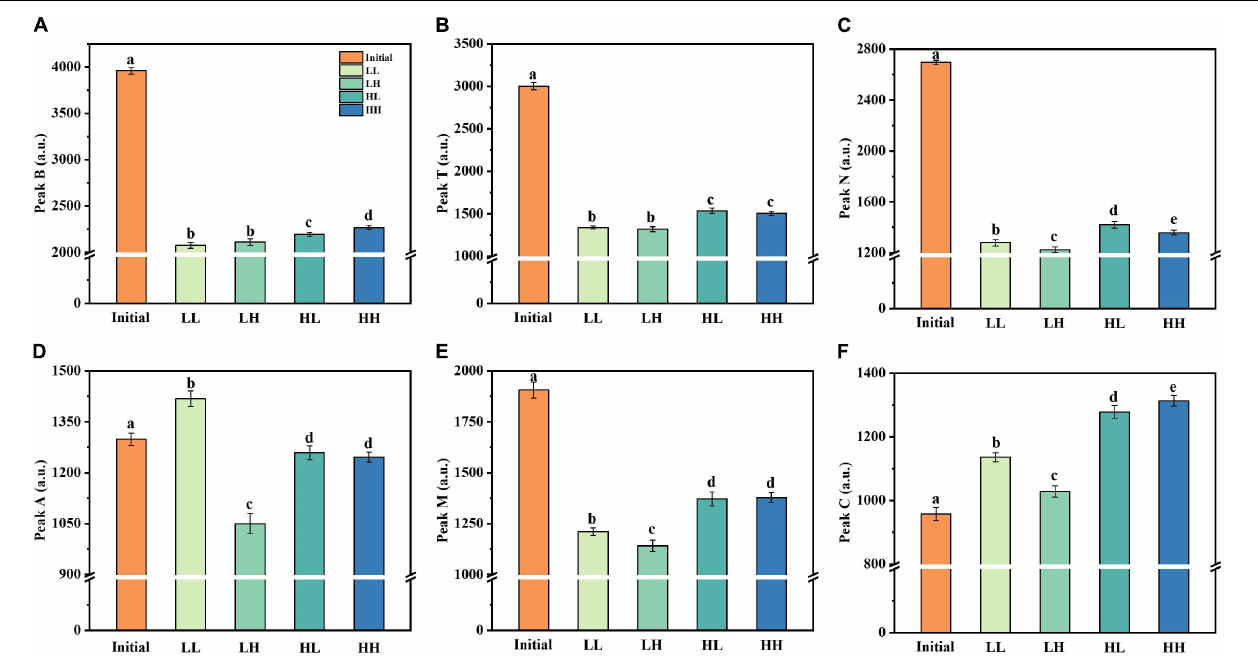
FIGURE 4 | Changes in fluorescence peaks (peaks B, T, N, A, M, and C) under warming and acidification conditions. (A–F) Represent peak B, peak T, peak N, peak A, peak M, and peak C respectively. Initial, initial value; LL, 27 ◦ C and 400 ppm; LH, 27 ◦ C and 1,000 ppm; HL, 31 ◦ C and 400 ppm; HH, 31 ◦ C and 1,000 ppm. All data are presented as mean ± SD ( n = 3). Error bars represent the standard error for duplicate cultures. Different letters (e.g., “a,” “b,” “c,” “d,” and “e”) represented significant difference ( p < 0.05), as determined by a one-way analysis of variance